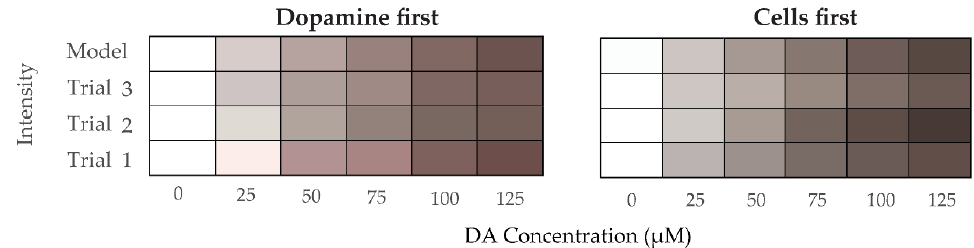
Figure 11. Visual comparison of RGB color intensities acquired experimentally and estimated by the model in (5) as per the trial and experiment.